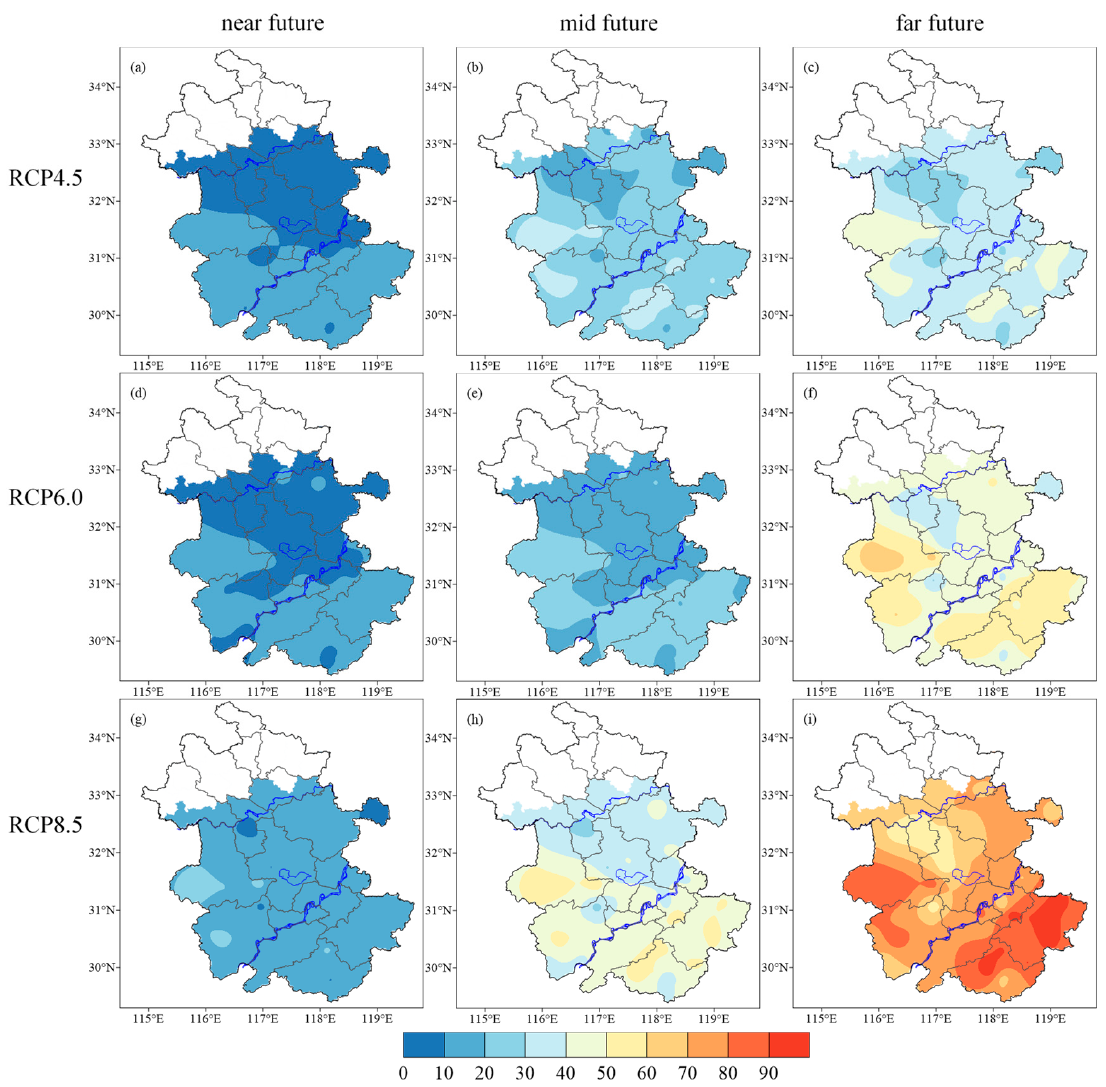
Figure 8. Spatial distribution of HSWI differences compared with the reference value in different periods from 2021 to 2099 under 3 RCPs in the area south of the Huai River in Anhui Province. ( a ) near future under RCP4.5; ( b ) mid-future under RCP4.5; ( c ) far future under RCP4.5; ( d ) near future under RCP6.0; ( e ) mid-future under RCP6.0; ( f ) far future under RCP6.0; ( g ) near future under RCP8.5; ( h ) mid-future under RCP8.5; ( i ) far future under RCP8.5.